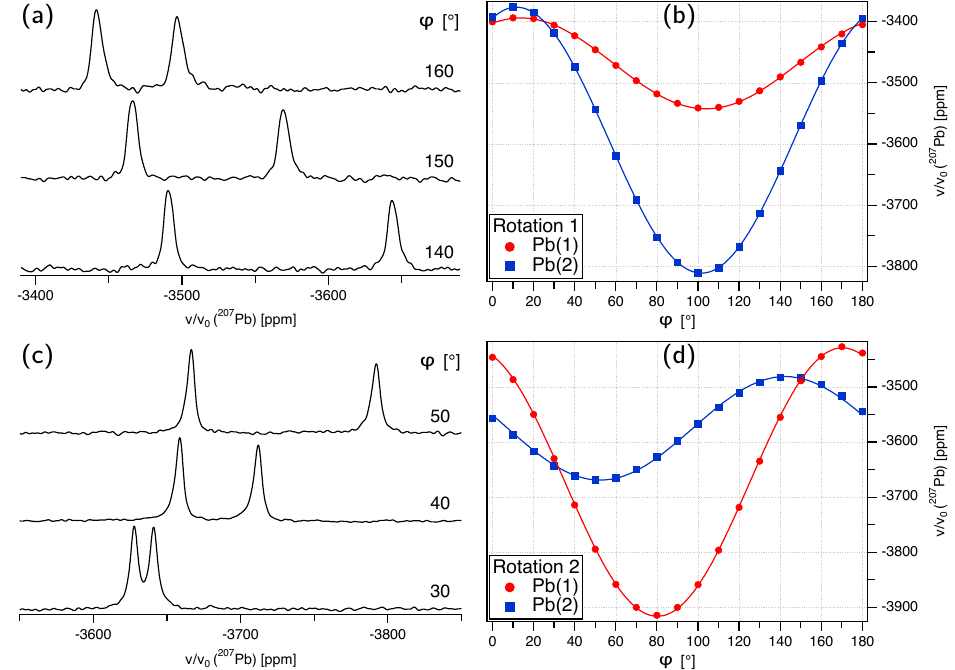
Figure 3. Left: 207 Pb NMR spectra of a single crystal of anglesite, PbSO 4 , rotated counter-clockwise by Figure 3. 207 Pb NMR spectra of a single crystal of anglesite, PbSO 4 , rotated counterclockwise by the the indicated angle j around the rotation axis ~ g 1 (top) and ~ g 2 (bottom) perpendicular to the external indicated angle ϕ around rotation axes (cid:126) g 1 ( a ) and (cid:126) g 2 ( c ), both perpendicular to the external magnetic field (cid:126) B 0 (varying signal intensity is due to the limited excitation width of the used spin–echo sequence). Full rotation pattern over 180 o for the two magnetically inequivalent 207 Pb at W YCKOFF position 4 c , acquired by rotating the anglesite crystal stepwise by 10 o around (cid:126) g 1 ( b ) and (cid:126) g 2 ( d ). Lines represent the fit of the experimental points to the CS tensor elements (see main text for